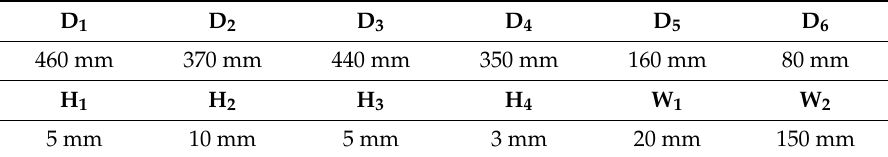
Figure 8. Structure of the pad used. Table 1. Geometrical dimensions of the pads.